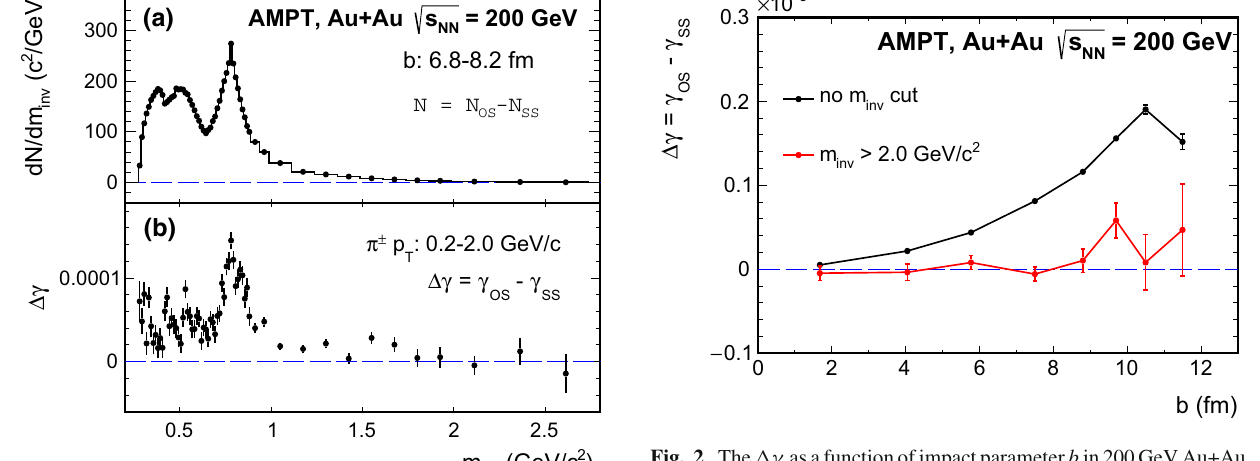
Figure1ashowsthe m inv distributionoftheexcessOSover